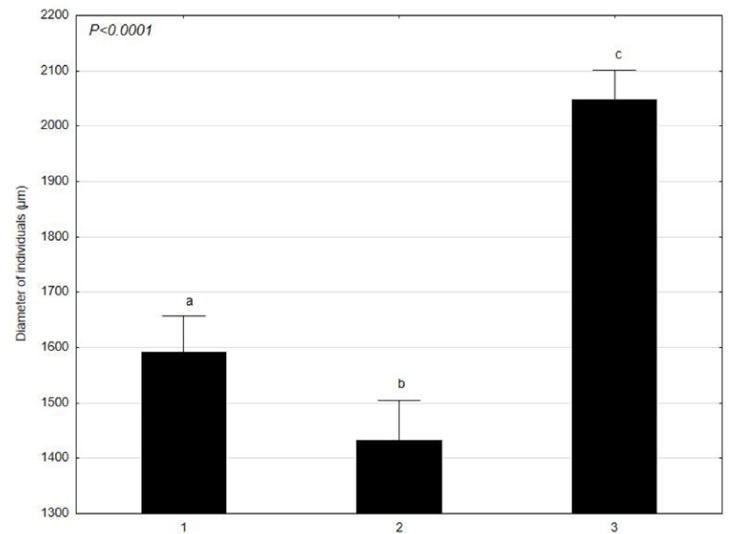
Figure 3. Mean values of L. minor feature (diameter of individuals) at different times (1–30 April 2021; 2–4 June 2021; 3–17 July 2021) presented using the Tukey multiple comparisons test. The bars indicate mean values. Error bars represent standard error. A, B, C determines the statistical significance between the analyzed features. A statistically significant result for p ≤ 0.05 was marked.